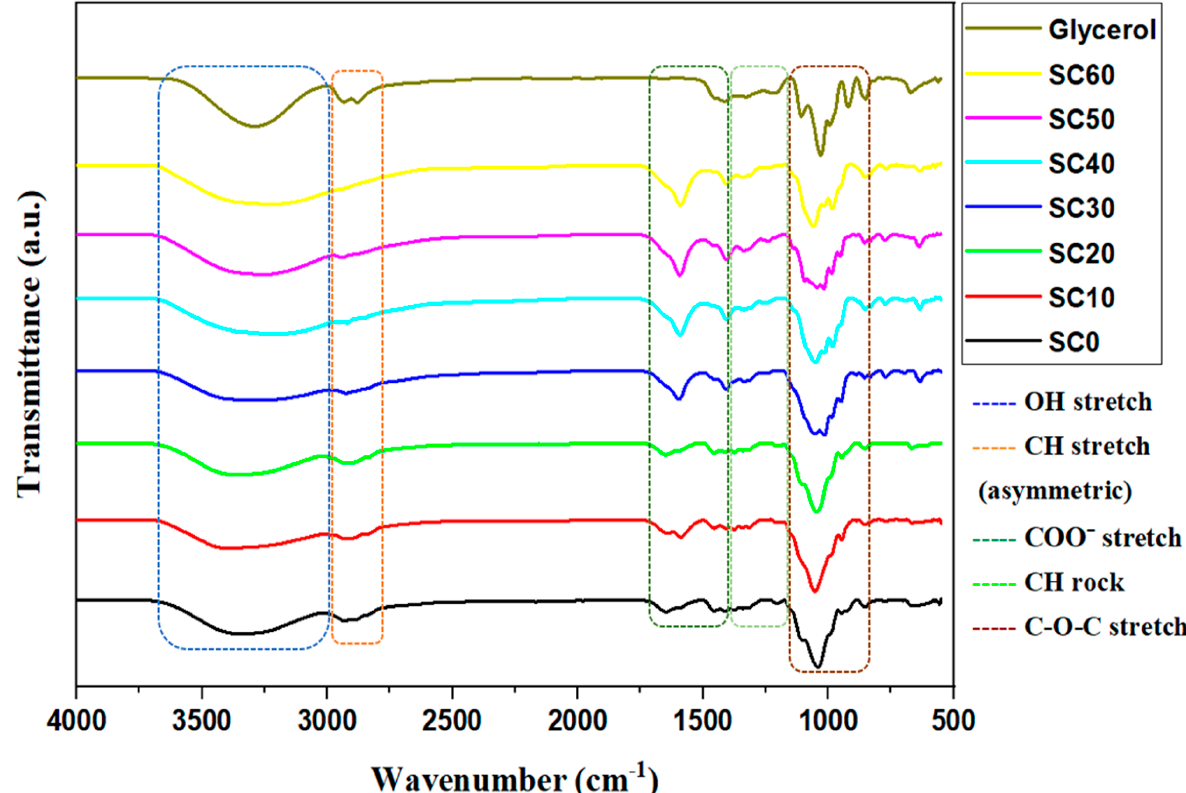
Figure 1. FTIR of unplasticized and glycerol-plasticized MC/PC/K 3 PO 4